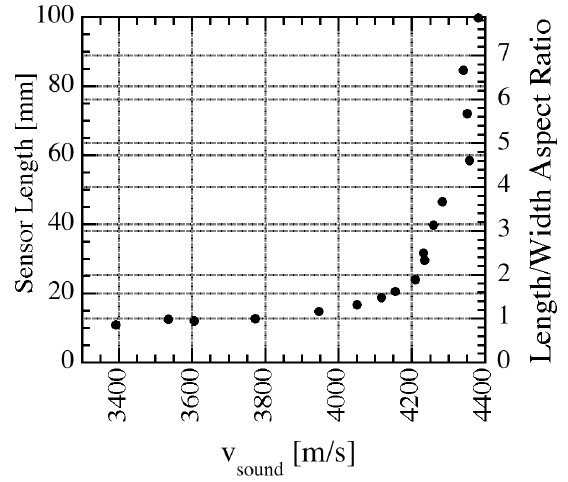
Figure 5. Velocity of sound in Metglas™ 2826MB sensors of 12.7 mm width at different lengths. Reprinted with permission from